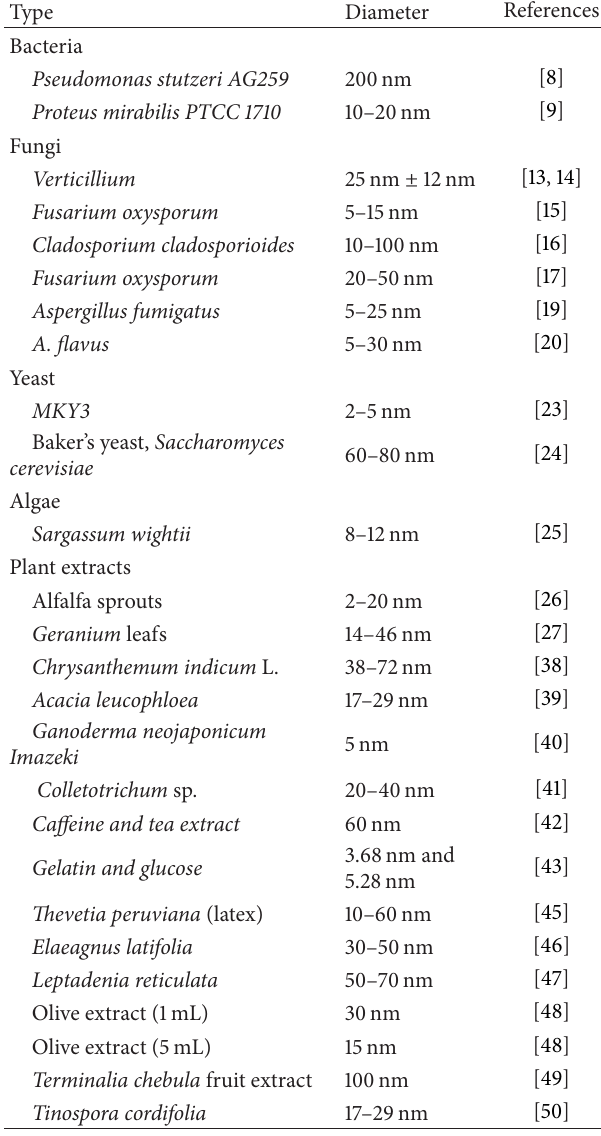
Table 1: Size dependent synthesis of silver nanoparticles via eco- friendly synthesis